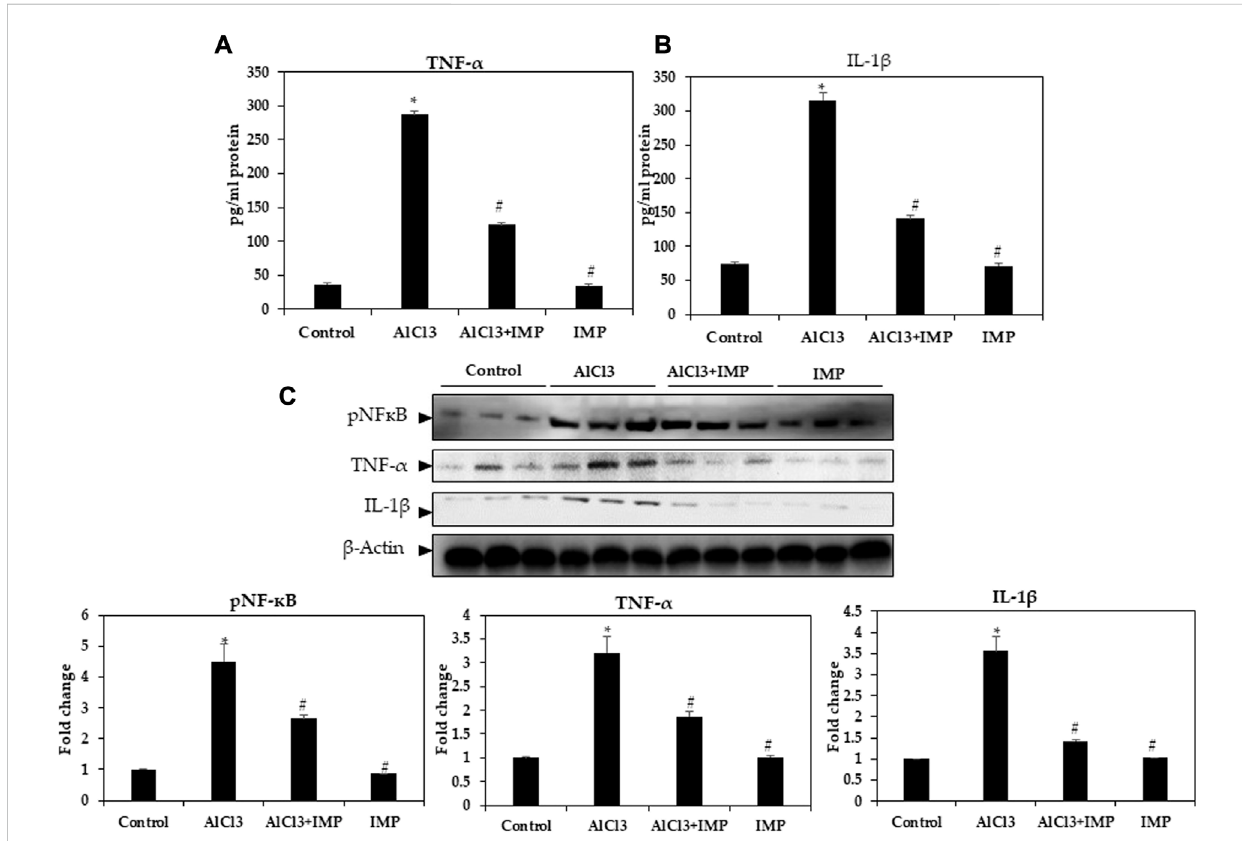
FIGURE 4 Level of pro-in fl ammatory cytokines in brain homogenates. (A) Level of TNF- α (pg/mg protein). (B) Level of IL-1 β (pg/mg protein). (C) Western blot analysisofNF- l Bandthepro-in fl ammatorycytokine(TNF- α andIL-1 β )expressioninbrainhomogenates.Thedifferencebetweenthetreatedgroupsand the control group was calculated; * p < 0.05, # p < 0.05 was considered statistically signi fi cant. Values are expressed as mean ± SD, n = 3. * p < 0.05 indicates signi fi cant differences between AlCl3 treated group and the control group. # p < 0.05 shows signi fi cant differences between AlCl3 alone and IMP with AlCl3.